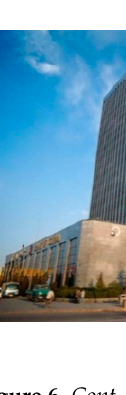
Figure 5. Ownership certificate of an estate building (source: http://news.focus.cn/zh/2015-03-07/6090778.html, accessed on 26 October 2021).